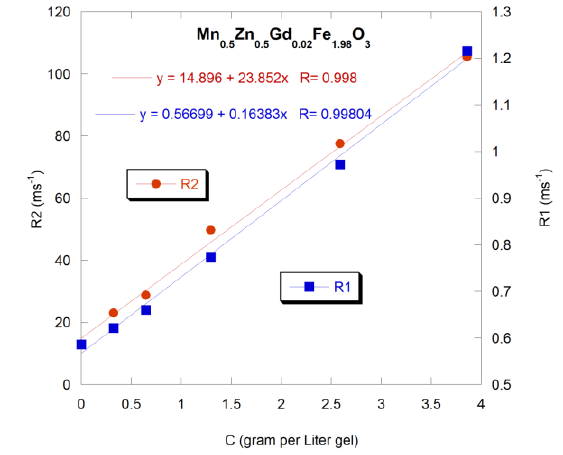
Figure 7. Linear relationship between the relaxation rates and nanoparticle concentration is demonstrated. The slope of the curves defines